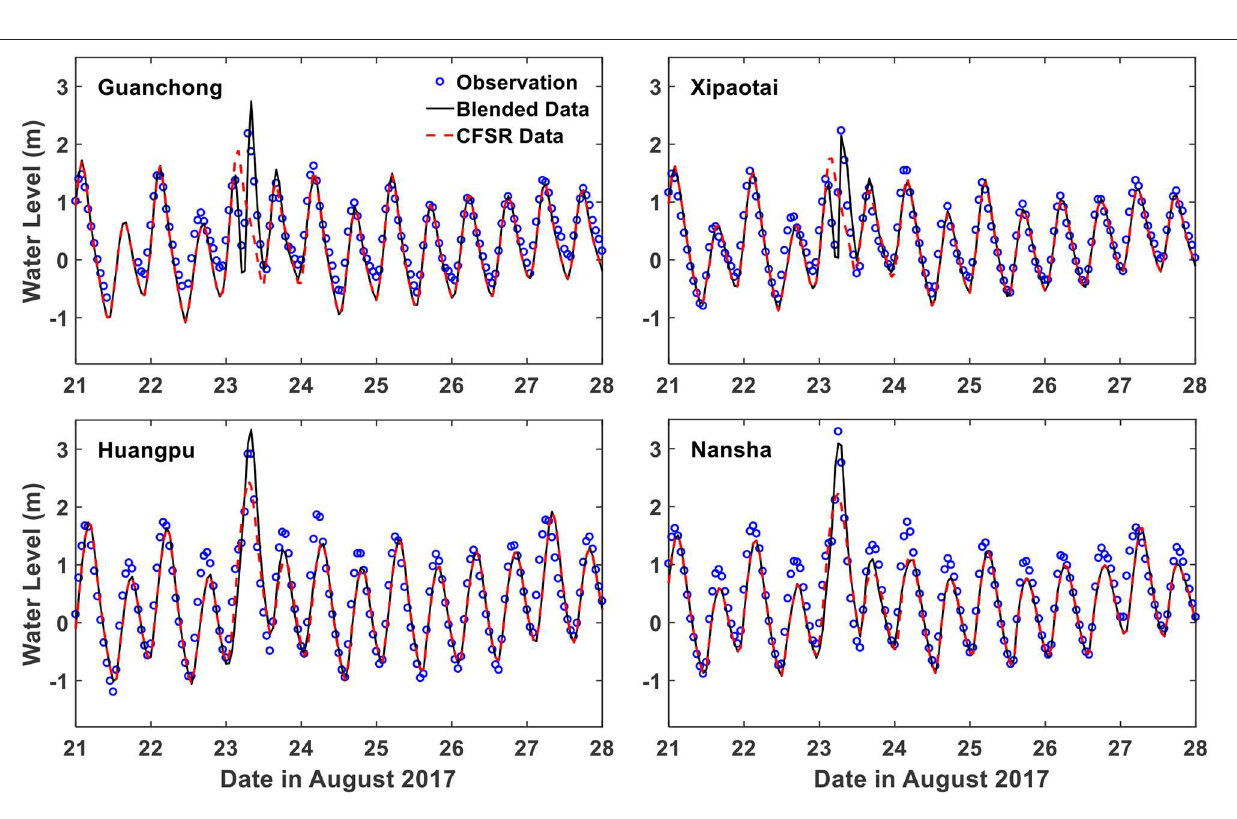
leads to the significant intensity of the local drop and rise of water level, whereas it is the fast translation speed of Hato that results in the sharp change in water levels from a local minimum to the maximum